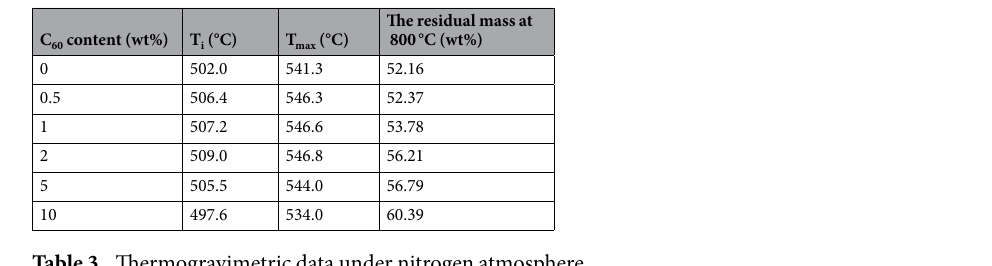
Table 3. Thermogravimetric data under nitrogen